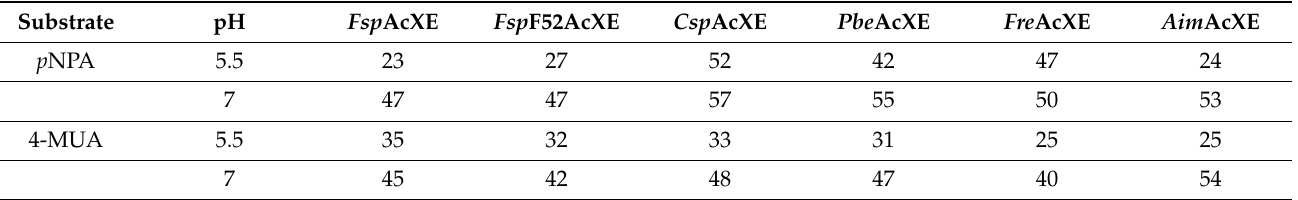
Table 1. Percentage of hydrolyzed substrate by the studied acetylxylan esterases in 2 h using 1 mM substrate and 40 ◦ C temperature ( n =